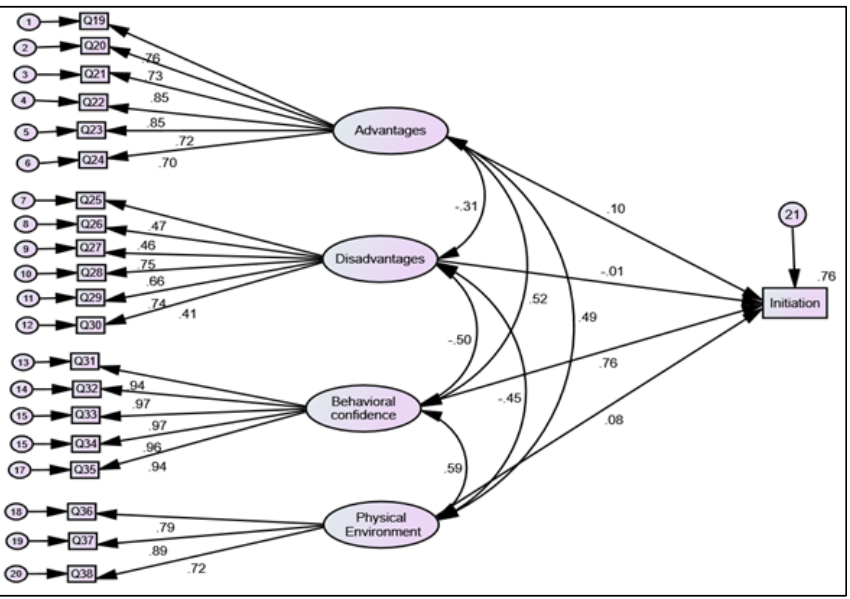
Figure 2. Structural equation modeling for initiation of sunscreen use behavior among Florida residents.